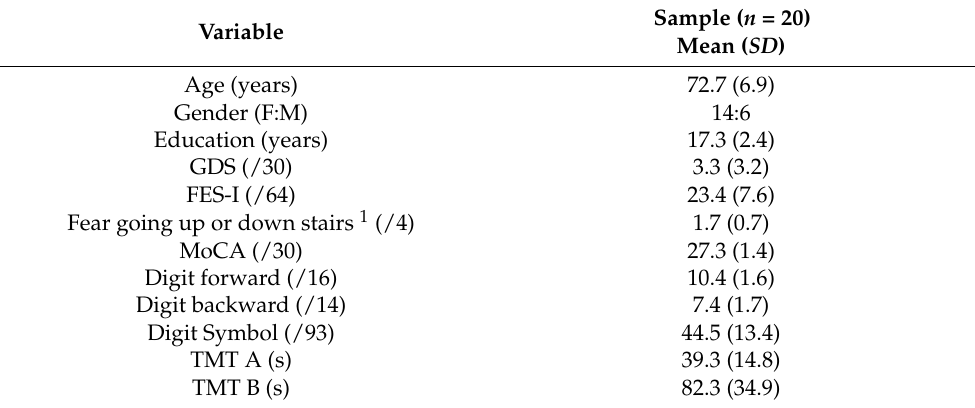
Table 1. Characteristics of study participants and neuropsychological test